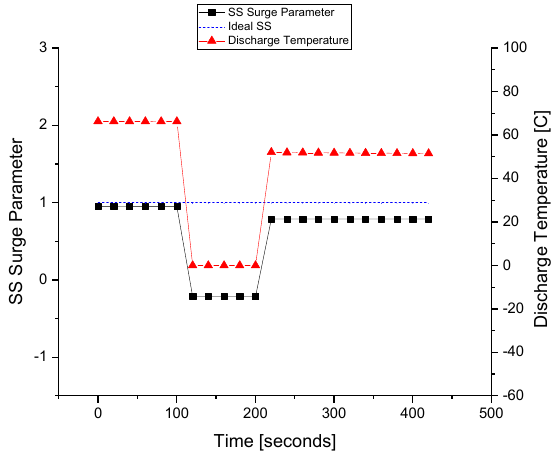
Figure 17. The fault tolerance in the discharge temperature sensor. The fault is tolerated for the discharge temperature sensor, and this improves the system reliability and prevents unnecessary flow across the ASV. When the wrong signal of the discharge temperature sensor is fed to the controller, the ASV is opened by the ASC. After that, the wrong or faulty signal is interrupted by the FTC and replaced by a healthy value, i.e., the estimated value obtained from the observer. The ASV response during the fault execution for the discharge temperature sensor is shown in Figure 18. The flow of the fluid across the ASV during the fault is a waste of energy, especially when the wrong signal of the surge is fed to the controller due to the fault in the sensors. The valve operates when the faulty T d signal is sent to the ASC at about 110 s. The fault is tolerated at about the 210 s when the valve is fully closed, and the system returns to normal despite the fault occurrence in the T d sensor.